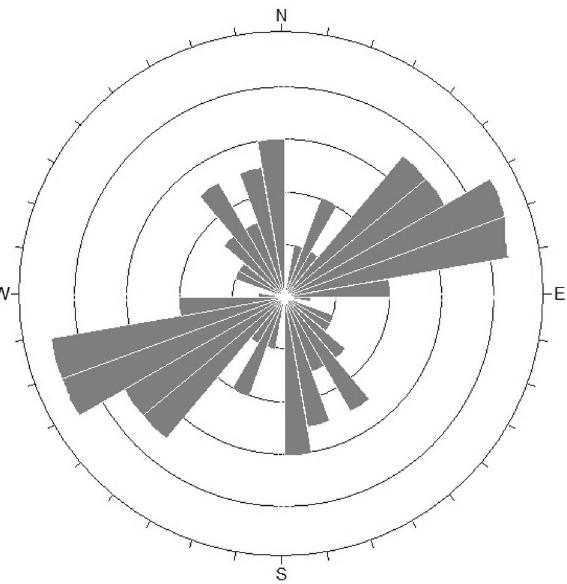
Figure 13. The distribution of deterministic structural plane of slope in Suichang Gold Mine National Mine